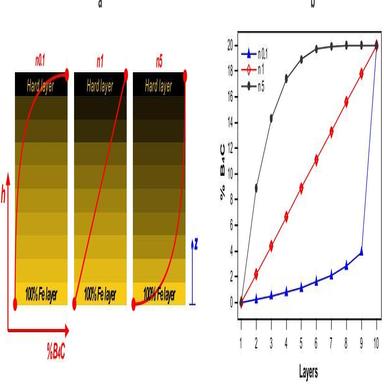
a) Schematic representation of FGM structure and compositional changes for three gradients, b) Changes in the reinforcement ratios (vol% B4C) in the layers with the increasing thickness (z) in the FGM (Vcmax: 20%).